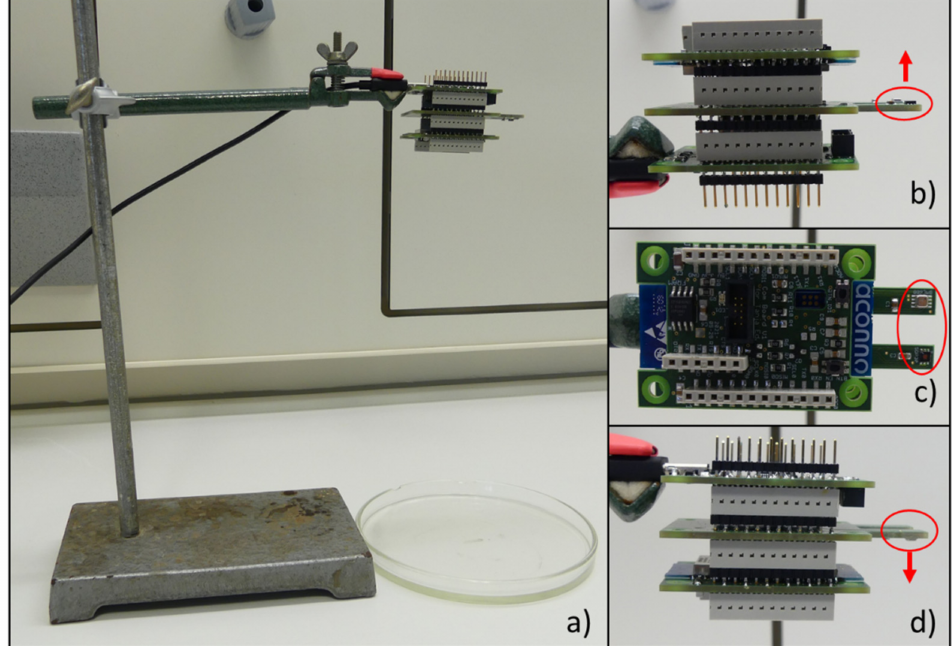
Figure 6. ( a ) Experimental setup in fume cupboard including the stand, petri dish and a sensor node; ( b ) sensor-node orientation: facing upwards; ( c ) sensor-node orientation: facing sideways; ( d ) sensor-node orientation: facing